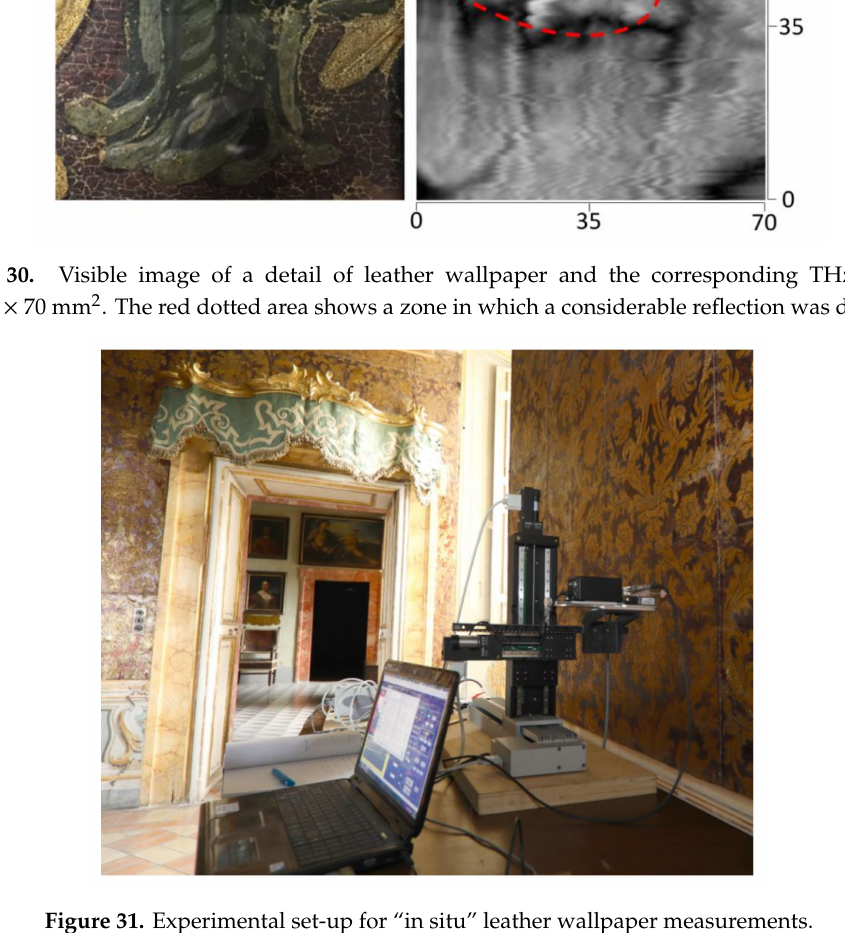
Figure 31. Experimental set-up for “in situ” leather wallpaper